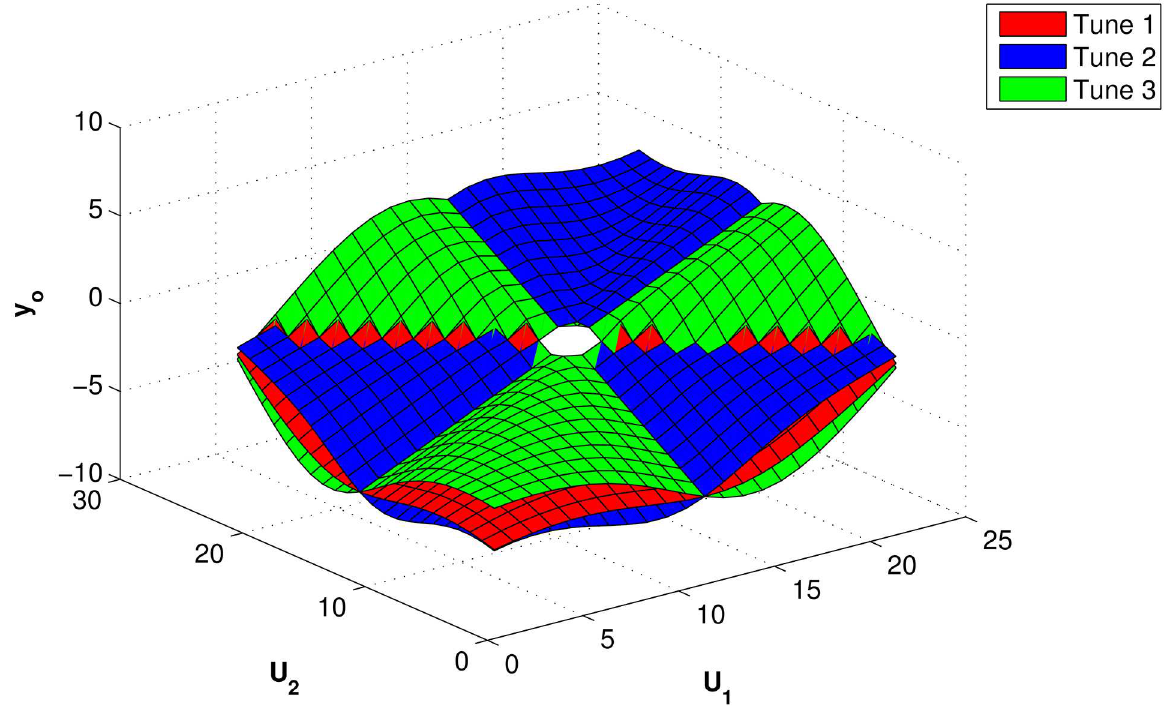
Fig 10. Surface representing analogical OR gate for different tuning parameter values.